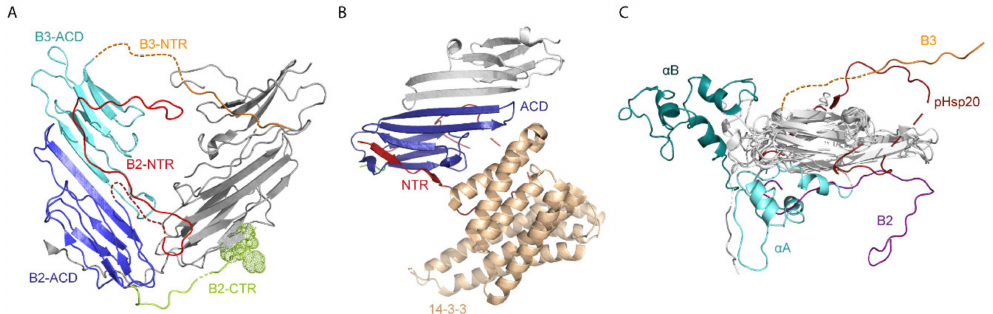
Figure 3. Complex formation and conformational diversity of NTRs. ( A ) Tetrameric assembly shows HspB2 and HspB3 in a 3:1 ratio (PDB: 6F2R) [64]. The crystal structure consists of two dimers. One built of two HspB2s (light grey, homodimer) and the other of HspB2 and HspB3 (heterodimer). The second one is formed by an interaction of the β 7-interface with their ACDs (B3–ACD: cyan and B2–ACD: blue). This dimeric structure is stabilized by an interaction of the HspB2–NTR (red, dashed lines are modeled) with the HspB3–ACD. Further stabilization is achieved by interactions with the neighboring homodimer via HspB3–NTR (orange, dashed lines modeled) and HspB2–CTR (light green, V-Y-I motif is highlighted with spheres). Short peptides which had not been assigned to any sHsps within the structure are excluded from visualization. ( B ) Part of the hetero-tetrameric complex (PDB: 5LTW) of phosphorylated Hsp20 (pHsp20) with 14-3-3 (wheat colored, only one of the two dimers is shown) [63]. Both proteins are known to build stable complexes together. Two unique interactions were formed: First pHsp20–NTR (red) interacts with the binding groove of 14-3-3 and second the pHsp20 ACD dimer interacts with one 14-3-3 protein. ( C ) Visualization of NTRs from five human sHsps confirms their di ff erent three-dimensional conformations. HspB2 (NTR: purple) and HspB3 (NTR: orange, dashed line modeled) were extracted from the X-ray structure of its hetero-oligomer (PDB: 6F2R) [64], as well as pHsp20 (NTR: red) from the sHsp–substrate complex (PDB: 5LTW) [63]. α A (NTR: cyan) and α B (NTR: petrol blue) are extracted from the two pseudoatomic models (PDB: 6T1R and 2YGD) [79,80]. All five monomeric structures are superimposed by their ACDs. To highlight the structural variability of the NTRs, ACDs and CTRs are colored in light